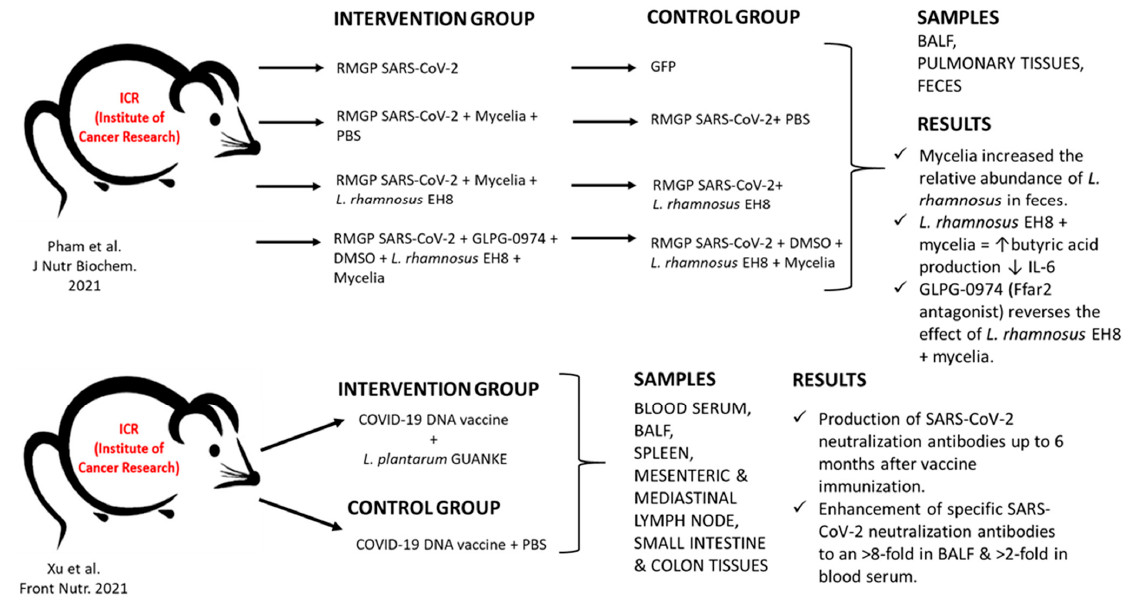
Figure 3. Preclinical studies of probiotic administration in COVID-19 infection [21,22]. RMGP: Recombinant membrane glycoprotein; GFP: green fluorescent protein; PBS: phosphate buffered saline; L. rhamnosus EH8: Lactobacillus rhamnosus strain EH8; DMSO: Dimethyl sulfoxide; GLPG- 0974: 4-[[(R)-1-(Benzo[b]thiophene-3-carbonyl)-2-methyl-azetidine-2-carbonyl]-(3-chloro-benzyl)- amino]-butyric acid, Ffar2: Free fatty acid receptor 2; BALF: Bronchoalveolar lavage fluid.